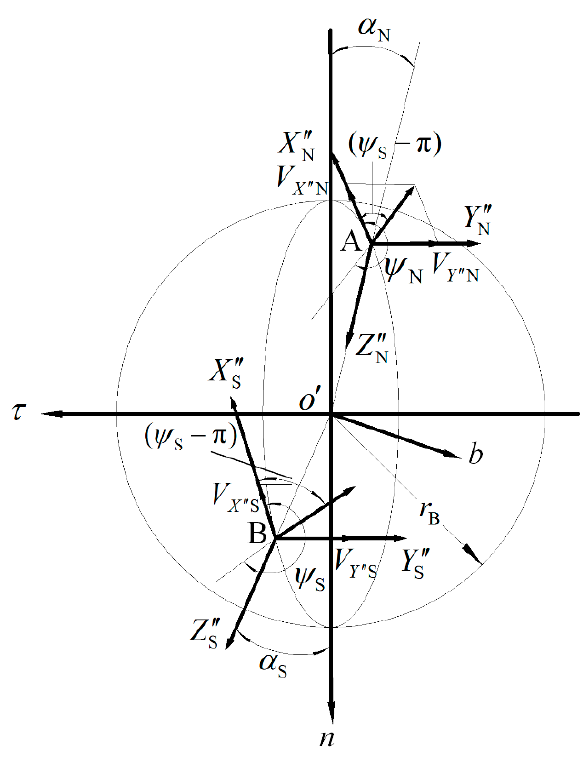
Figure 7. Formation of slip angle in contact area.